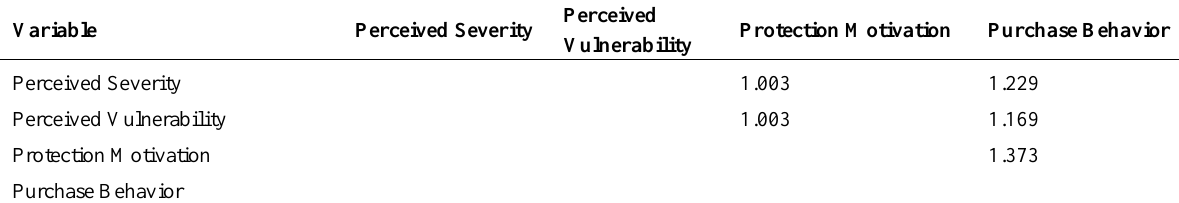
Table 3: Collinearity Test